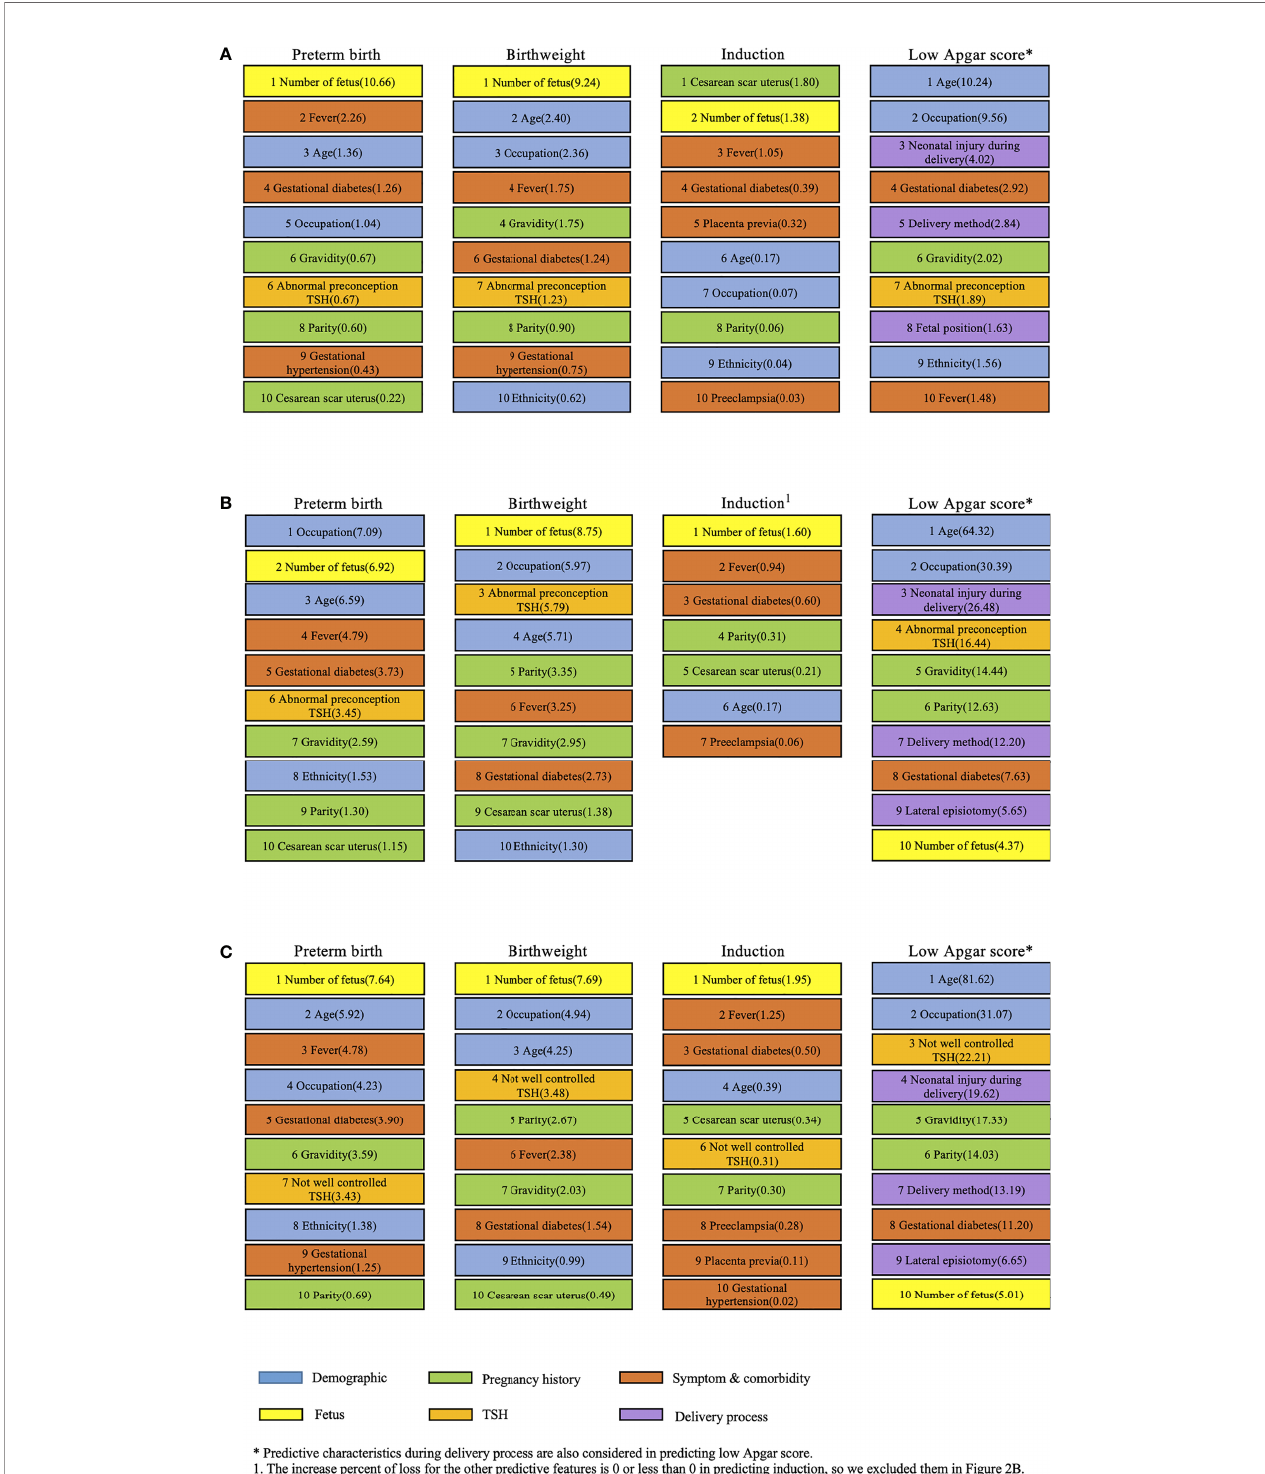
FIGURE 2 | Leading predictive features (%incloss) for four birth outcomes in both analyses of subjects. (A) Leading predictive features for four birth outcomes among women in the fi rst analysis with abnormal preconception TSH based on the XGBoost model. (B) Leading predictive features for four birth outcomes among women in the second analysis with abnormal preconception TSH based on the XGBoost model. (C) Leading predictive features for four birth outcomes among women in the second analysis with not-well-controlled TSH based on the XGBoost